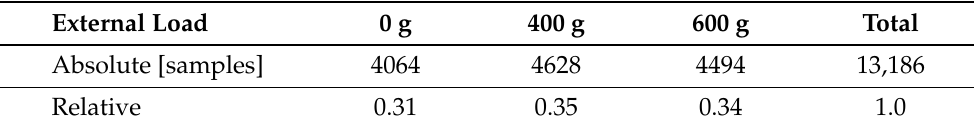
Table 5. Absolute and relative amount of adapted data points per external load for all subjects.